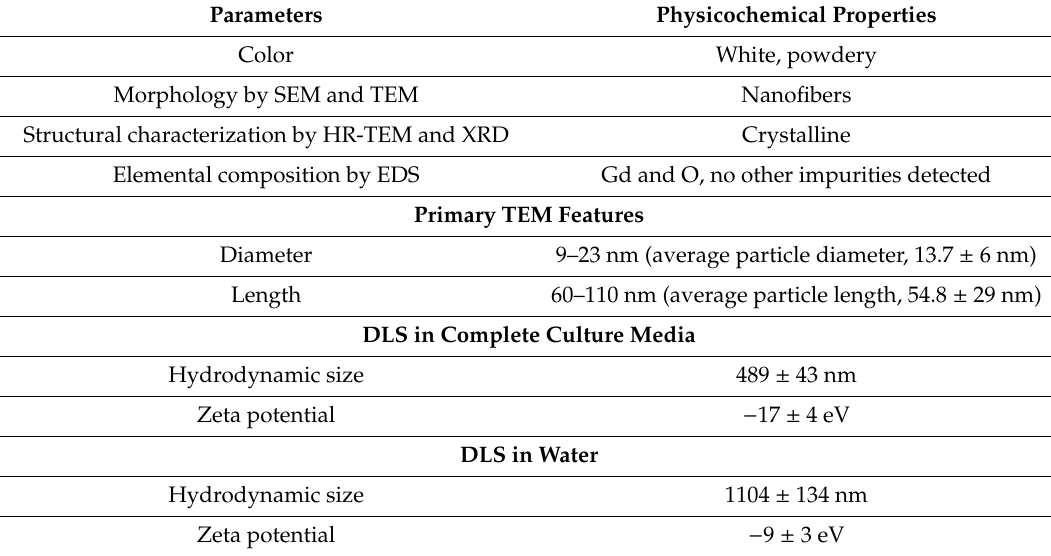
Figure 1. Shape and size of gadolinium oxide (GO) nanoparticles (NPs) characterized by TEM image captured at ( A ) 50 nm and ( B ) 20 nm. High resolution TEM image captured at ( C ) 2 nm depicts crystal plane. ( D – F ) SEM, EDS and XRD images of GO NPs, respectively. Table 1. Summary of physicochemical characterization data of GO nanoparticles.